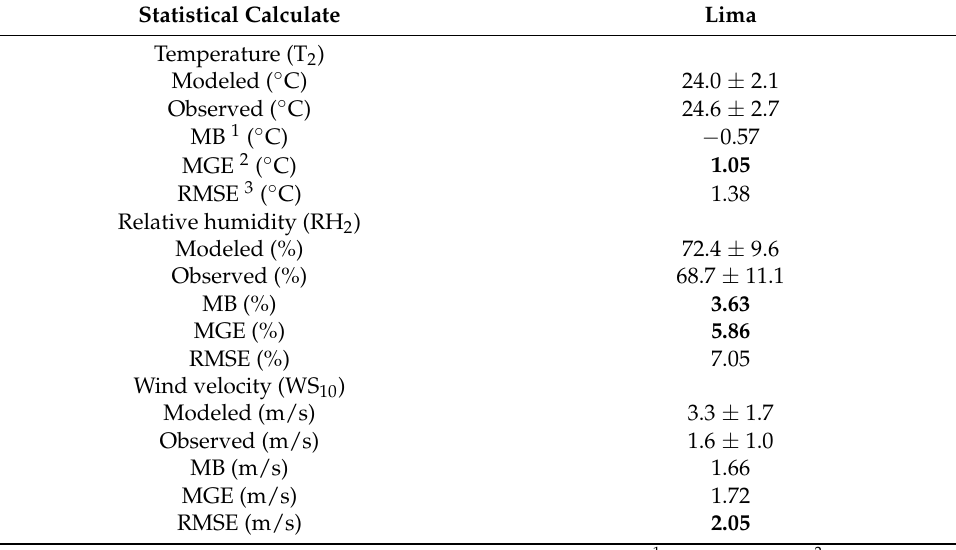
Table 3. Comparison of meteorological variables for Lima for case-control